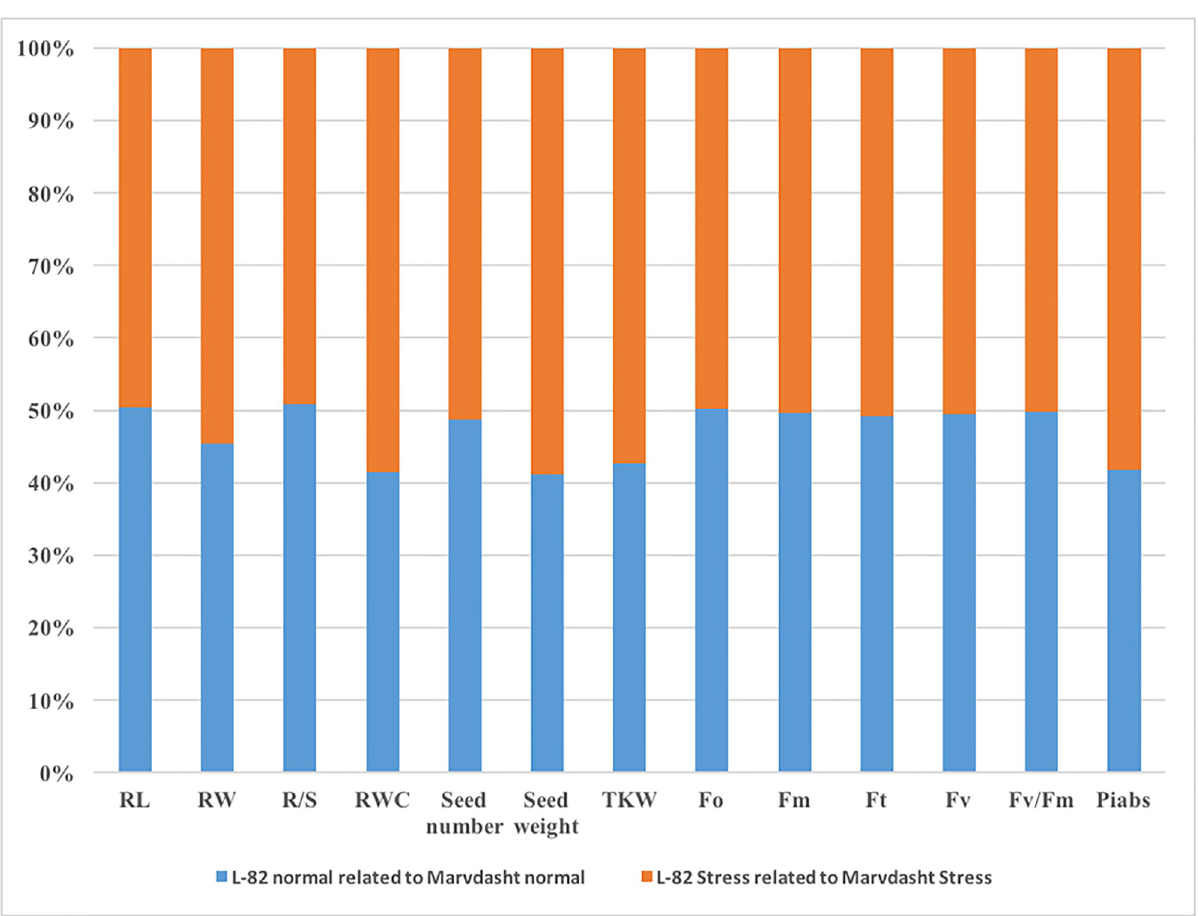
Fig 1. The value of each parameter in resistant landrace relative to the corresponding value of the susceptible genotype. Fo is the initial/minimal fluorescence; Fm is the maximal fluorescence value; Ft is the fluorescence intensity at time t; Fv is variable fluorescence, Fv = Fm–Fo; Fv/Fm represents the maximum quantum yield of Photosystem II (PSII); and PIabs is the performance index for the photochemical activity [30].